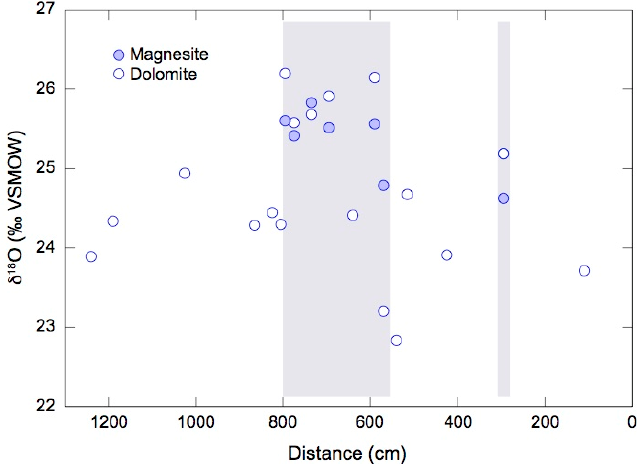
Figure 6. Transect of oxygen isotope ratios of magnesite and dolomite across the south wall of the Dobbie mine. Gray shows the location of magnesite ore.